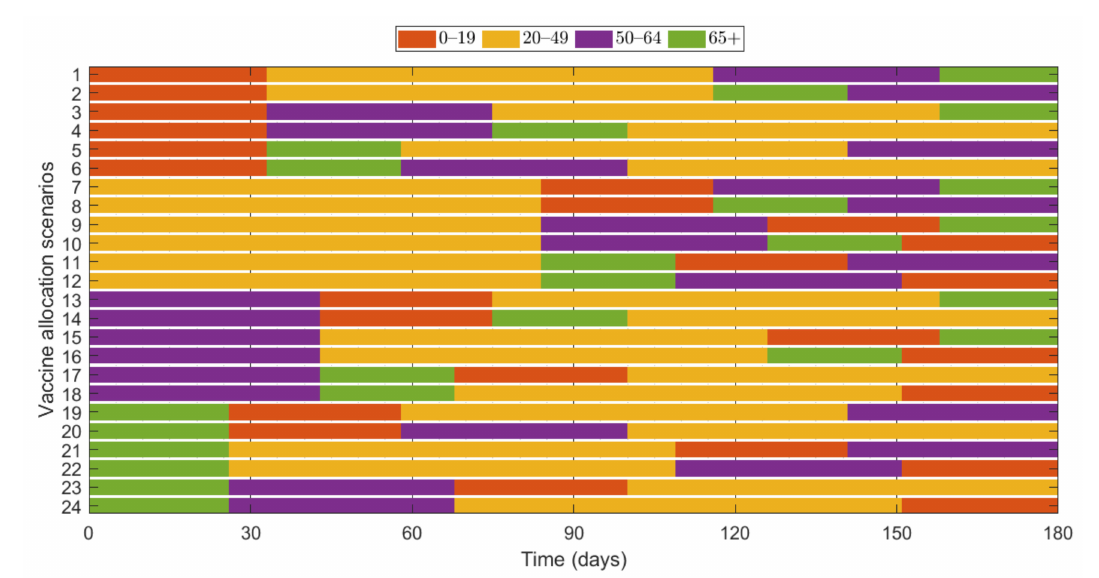
Figure 12. Scenarios of vaccination allocation orders.